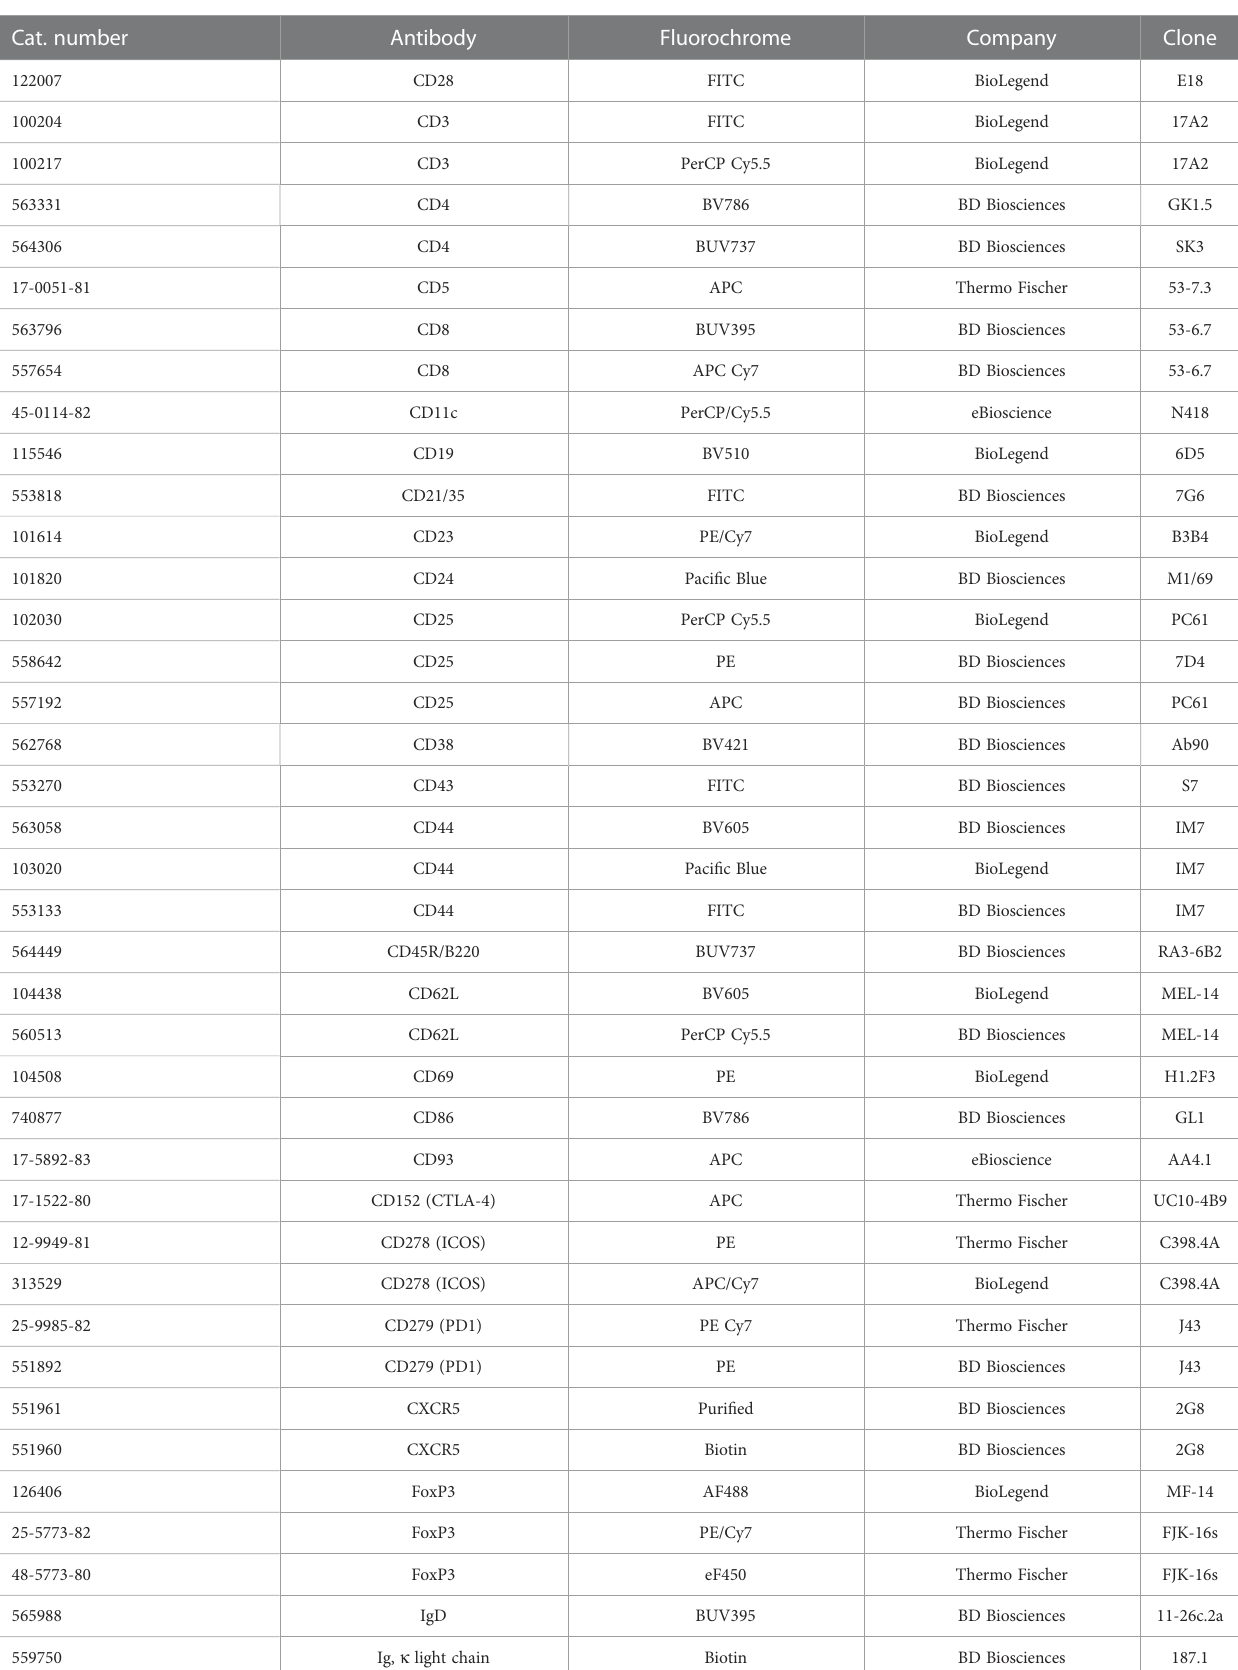
TABLE 1 Antibodies used for fl ow cytometric analyses of mouse hematopoietic cells. Cat.